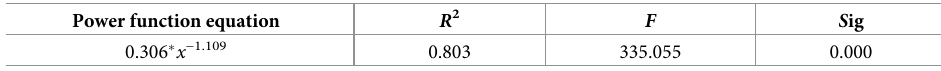
Table 1. Fitting the distribution of inter-city freight demand network strength in six provinces of central China during the epidemic